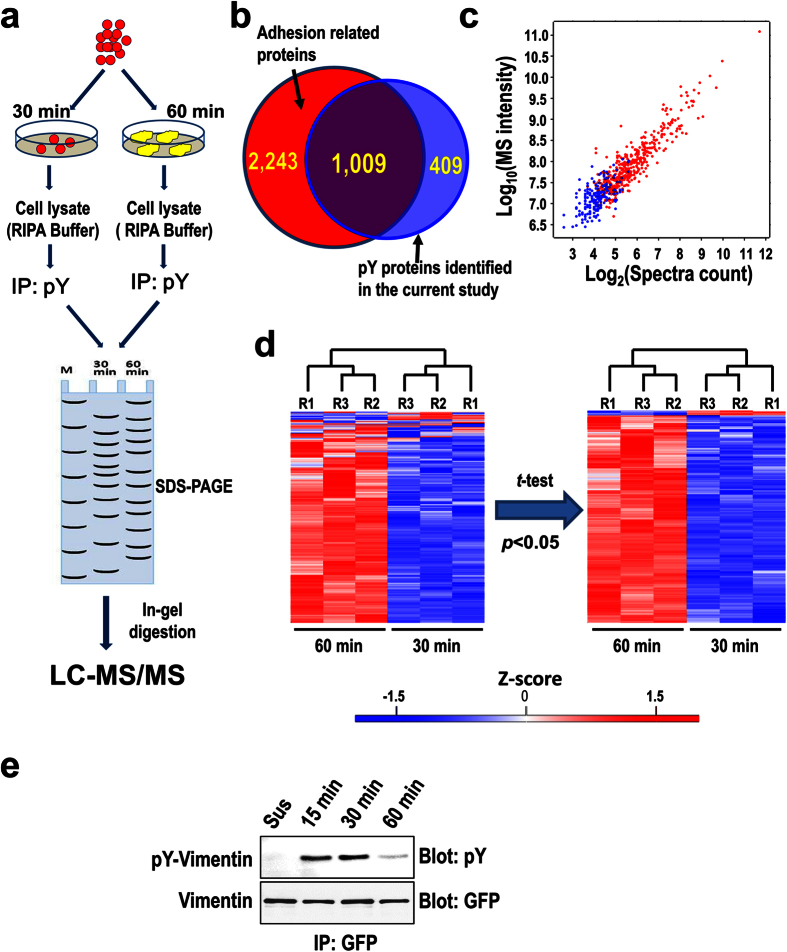
Quantitative proteomic analysis of pY proteins in the early and the active stages of migratory cells.(a) Schematic representation of the strategy for the proteomic analysis of the pY proteins. (b) The Venn diagram shows the comparison of the pY proteins identified in the current study with the adhesion related proteins identified by Schiller H. et al.12, The numbers of uniquely-identified and overlapping proteins from both studies are shown in the diagram. (c) The 2-D scatter-plot shows the spectral counts (x-axis) and MS intensities (y-axis) for all proteins containing quantitative information for all three replicates in at least one time point. The blue dots represent proteins containing quantitative information for all three replicates at only one time point, the red dots represent proteins with quantitative information for all three replicates at both time points. (d) Evaluation of the reproducibility of the quantitation using clustering analysis. The Z-scores of the normalized MS intensities of the 447 proteins with sufficient quantitative information (as indicated by the red dots in panel c) are color-coded to show the relative protein abundance (red: high, blue: low), and hierarchical clustering analysis was performed using the software Perseus with default parameters. Student’s t-test was used to filter out the proteins quantitated with low reproducibility (p < 0.05), which reduced the number of proteins from 447 to 371. The scale bar indicates the Z-scored values of MS intensities. (e) Validation of downregulation of pY-Vimentin at 60 min by immunoprecipitation and Western-blotting. The cells expressing GFP-Vimentin were allowed to adhere on 5 μg/ml fibronectin for the indicated times or kept in suspension (Sus) as indicated, the cells were then harvested and lysed. The fusion protein was immunoprecipitated from the WCLs using anti-GFP antibody, the pY level of immunoprecipitated GFP-Vimentin was detected by Western-blotting using anti-pY antibody, and the total level of GFP-Vimentin was detected by Western-blotting using anti-GFP antibody.